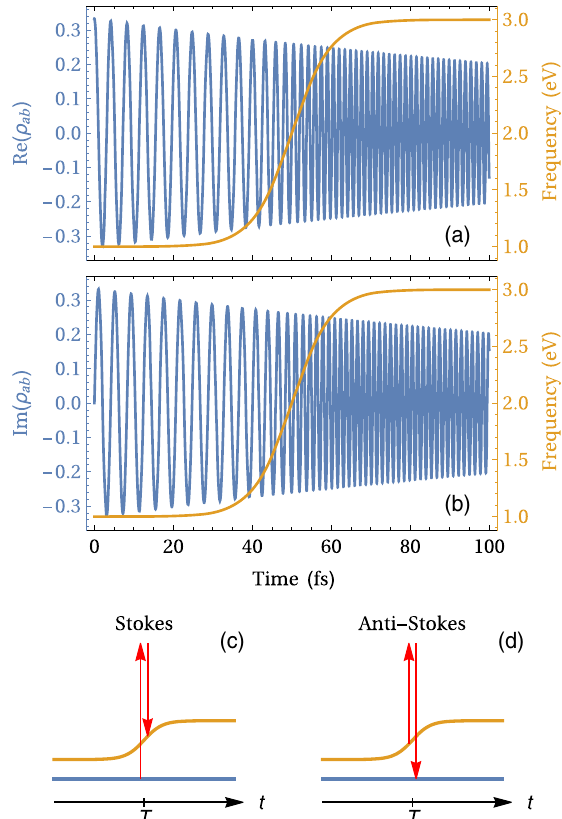
FIG. 6. Time-dependent frequency model. (a),(b) Evolution of t Þ [Eq. (18), yellow curves], the time-dependent frequency ω ba ð along with the (a) real and (b) imaginary parts of the correspond- t Þ [Eq. (20), blue curves]. (c) Stokes- and ing coherence ρ ab ð (d) anti-Stokes-type contributions to the TRUECARS signal between states (blue) a and (yellow) b . The red arrows represent the off-resonant stimulated Raman